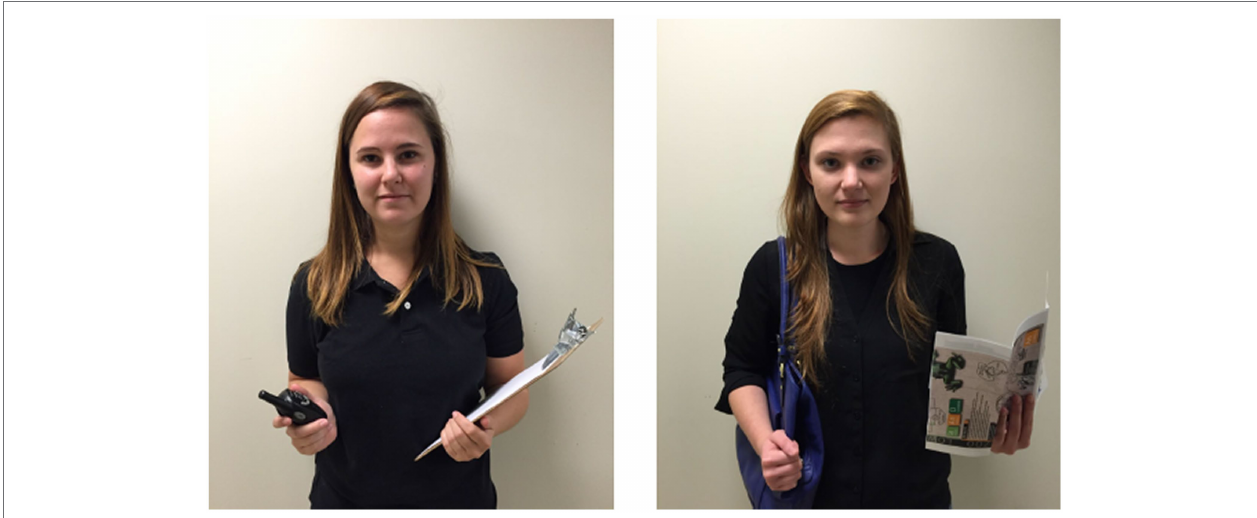
FIGURE 1 | Sample photographs of “Jess the zookeeper” and “Kim the mom,” the trained researchers who acted in informant roles for the purpose of the